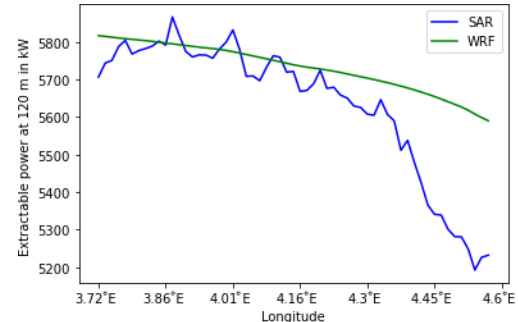
Figure 12. Extractable wind power coastal gradient at 120m on a horizontal line at the top of Zone 2, estimated by WRF and by SAR